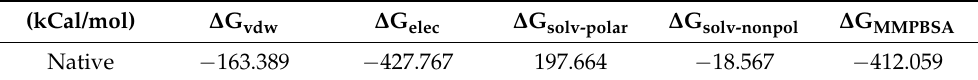
Table 3. Calculation of binding free energy ( ∆ G) and components of ligand binding energy at the site of binding. (kCal/mol) ∆ G vdw ∆ G elec ∆ G solv-polar ∆ G solv-nonpol ∆ G MMPBSA Native − 163.389 − 427.767 197.664 − 18.567 −